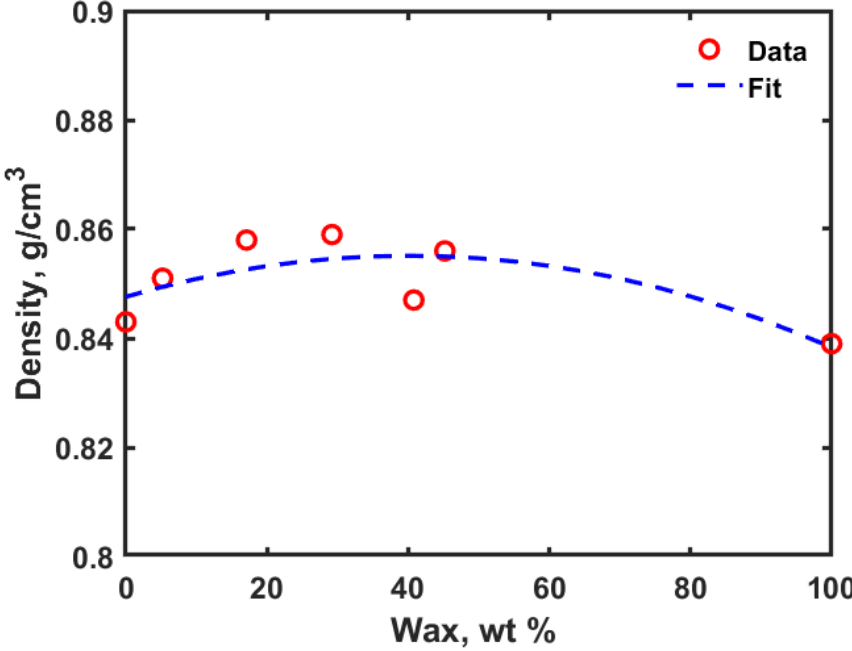
Figure 2. Density versus weight percent of wax in the PE-nonacosan-10-ol systems.